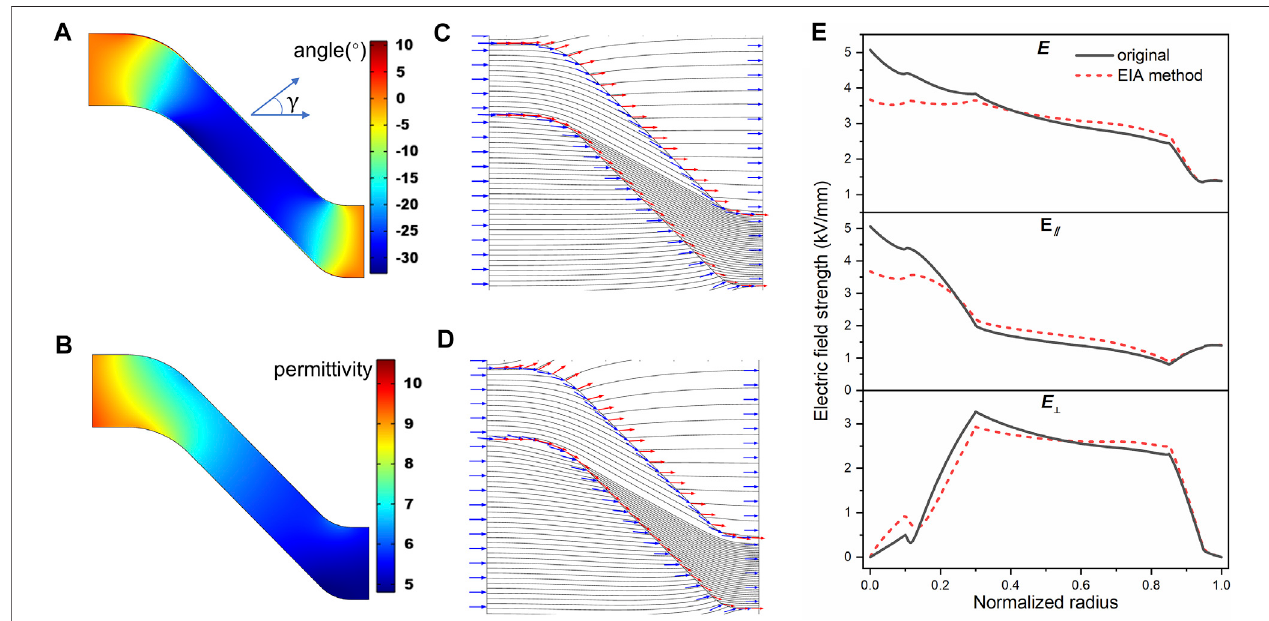
FIGURE7| Resultsofsimulation. (A) Thedirectionoflocal fi llerorientation(angletohorizontalaxis), (B) composite ’ seffectivepermittivityinthedirectionoflocal fi ller orientation, (C) electric fi eld in the original insulator, (D) electric fi eld in the insulator fabricated by the EIA method, and (E) electric fi eld along the concave surface of the basin insulator.